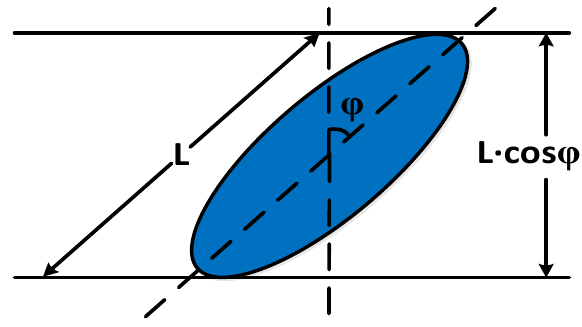
Figure 4. The target echo broadening.